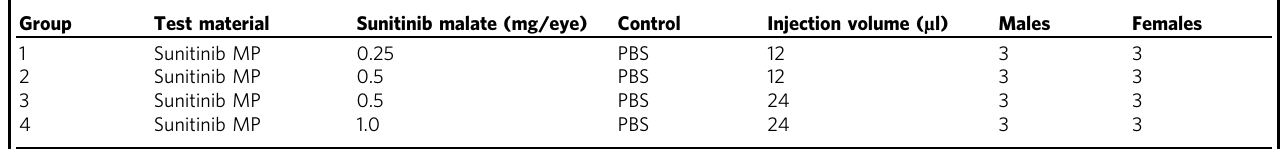
Table 1 Ocular tolerability and safety in Yucatan